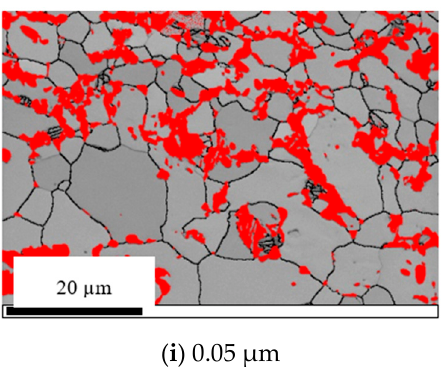
Figure 5. The morphology and distribution of retained austenite in TRIP780 steel at different step sizes ( a : 1.0 μ m; b : 0.5 μ m; c : 0.4 μ m; d : 0.3 μ m; e : 0.25 μ m; f : 0.20 μ m; g : 0.15 μ m; h : 0.10 μ m; i : 0.05 μ m).